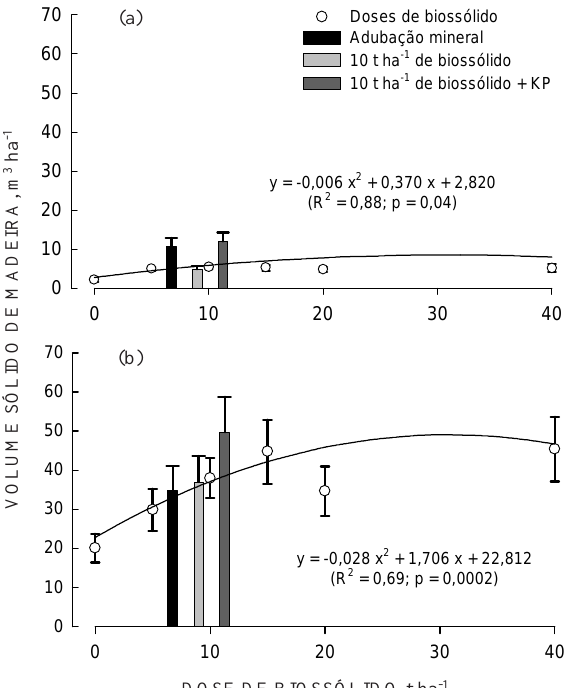
DOSE DE BIOSSÓLIDO,t ha